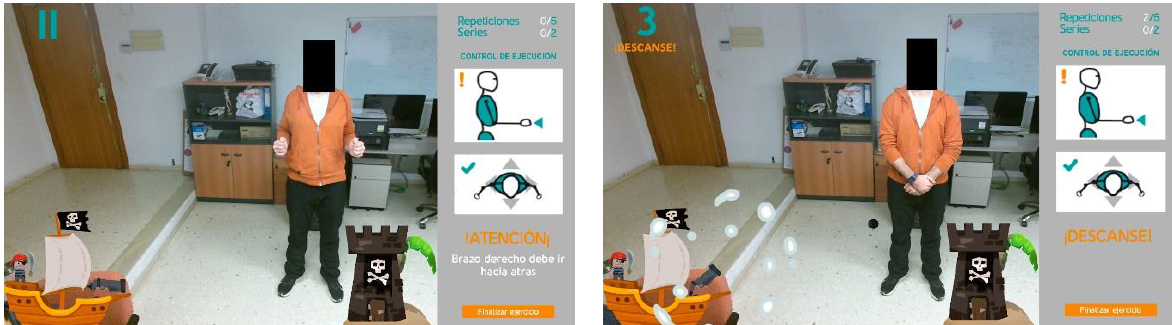
Figure 11. Gamification environment designed for isometric scapular retraction. On the left, while the user holds muscle tension, the cannon gains firepower. On the right, if the accumulated power is sufficient, the projected bullet (black ball in the center) will hit the